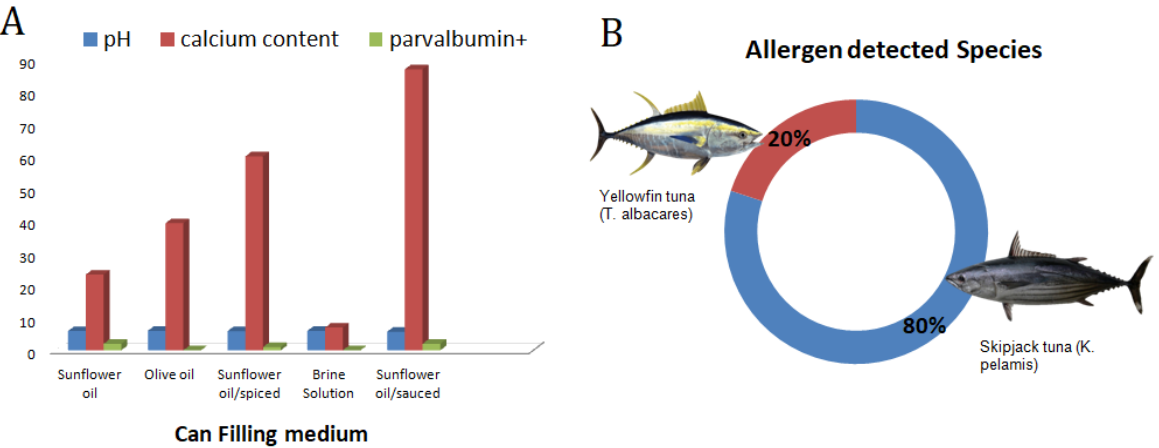
Figure 2A: Can filling medium impacts, Figure 2B: Tuna sub-species impact on the fish allergen.